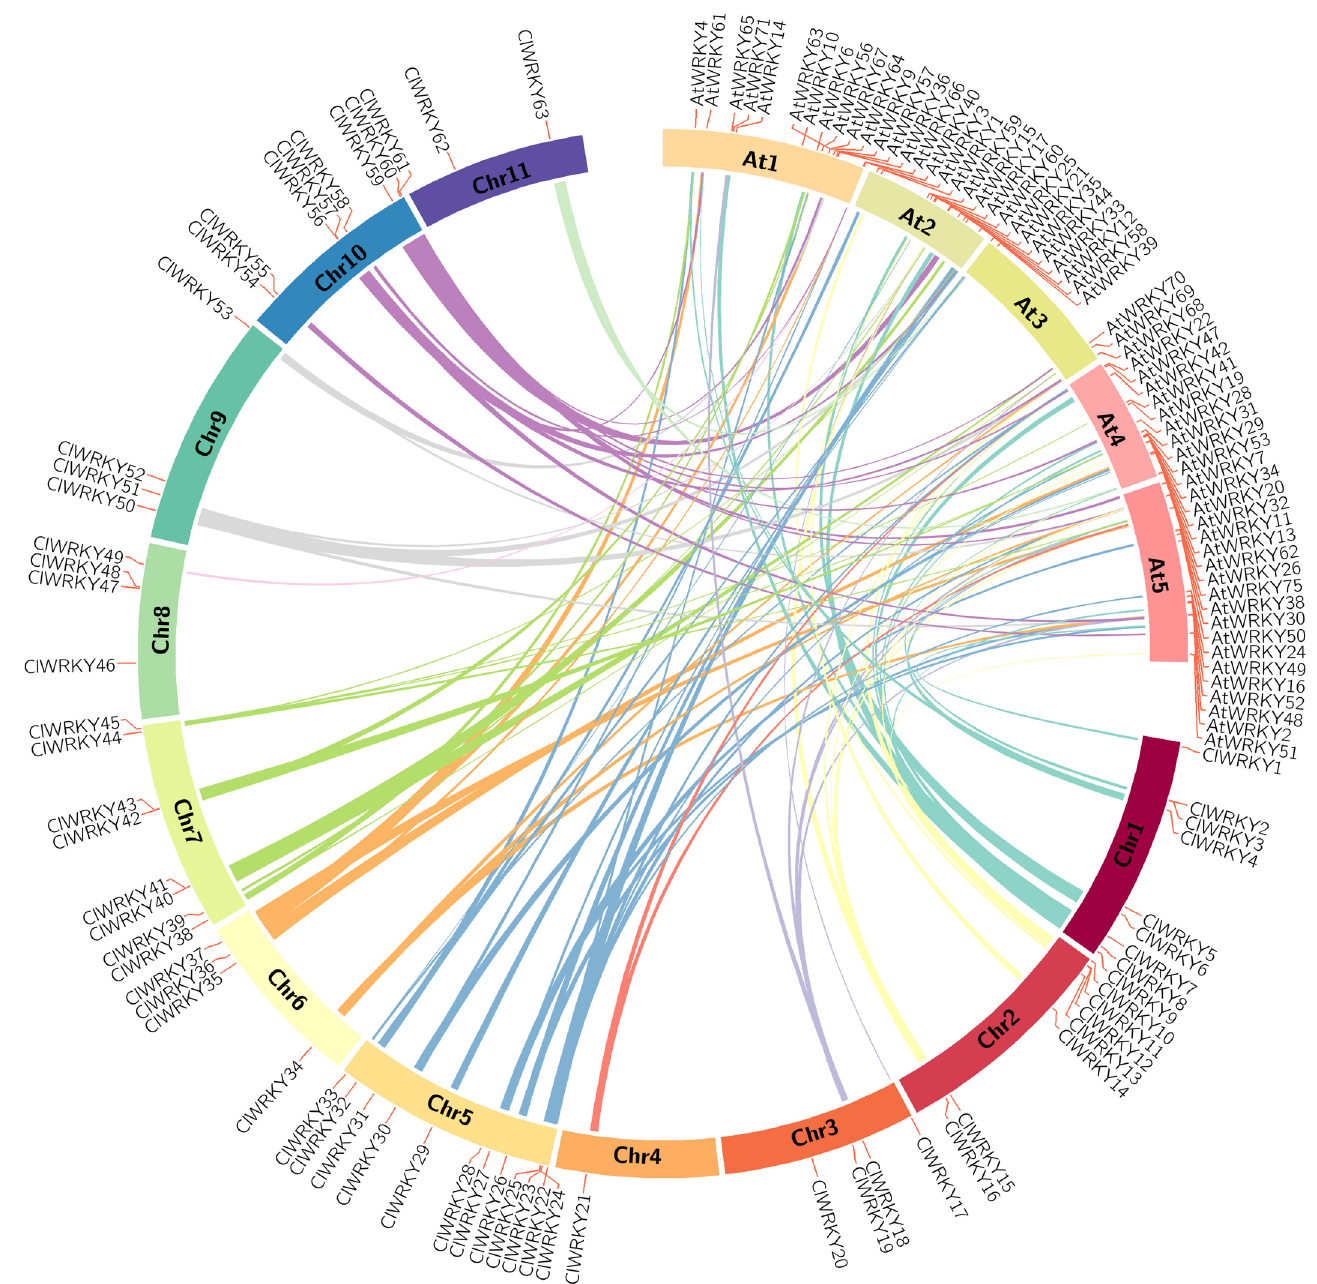
Fig 6. Synteny analysis between watermelon and ArabidopsisWRKY genes. The chromosomes of watermelon and Arabidopsis are depicted as a circle. Colored curves denote the details of syntenic regions between watermelon and Arabidopsis WRKY genes.